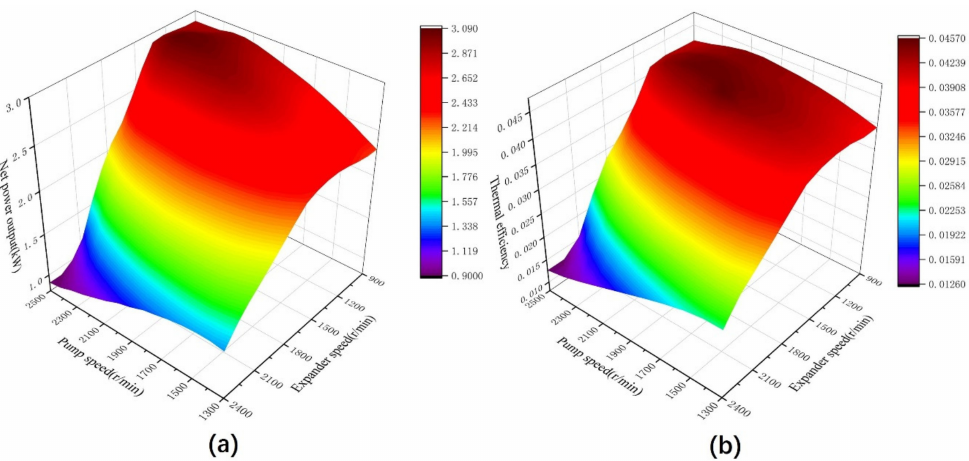
Figure 5. Results of the ORC system when the engine operates under the rated power condition: ( a ) The net power output and ( b ) the thermal e ffi ciency.